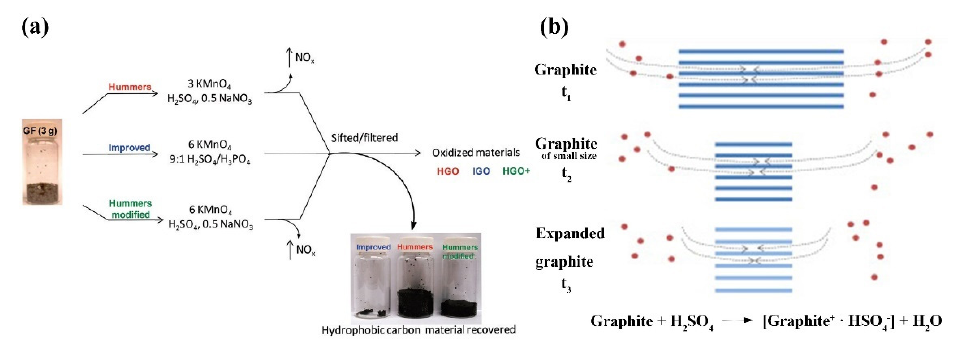
Figure 4. ( a ) Graphite flakes (GF) were used as raw material to prepare improved GO (IGO), Hummers GO (HGO), and Hummers modified (HGO + ) using three different methods. Reprinted with permission from Ref. [71]. Copyright 2010, Elsevier. ( b ) Schematic diagram of GO preparation by spontaneous expansion using expanded graphite as a precursor. Reprinted with permission from Ref. [72]. Copyright 2013,